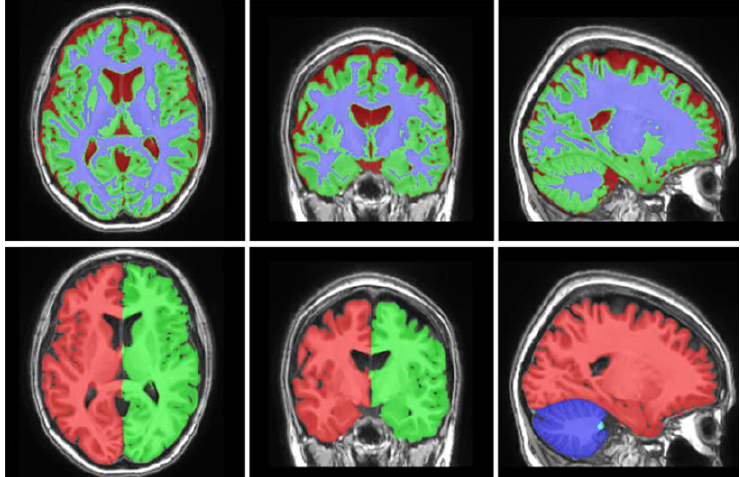
Figure 1. Brain gray and white matter discrimination and macrostructures with automated magnetic resonance imaging (MRI) brain morphometry.